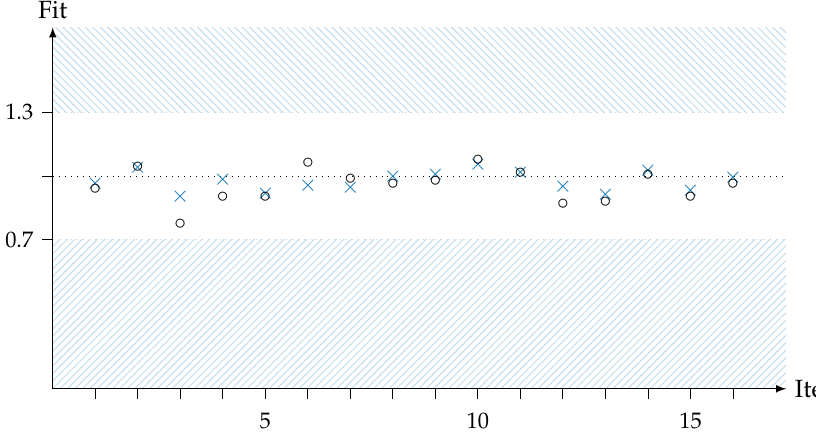
Figure 1. Infit MNSQ (crosses) and Outfit MNSQ (circles) for all items of the concept inventory. See text for details.